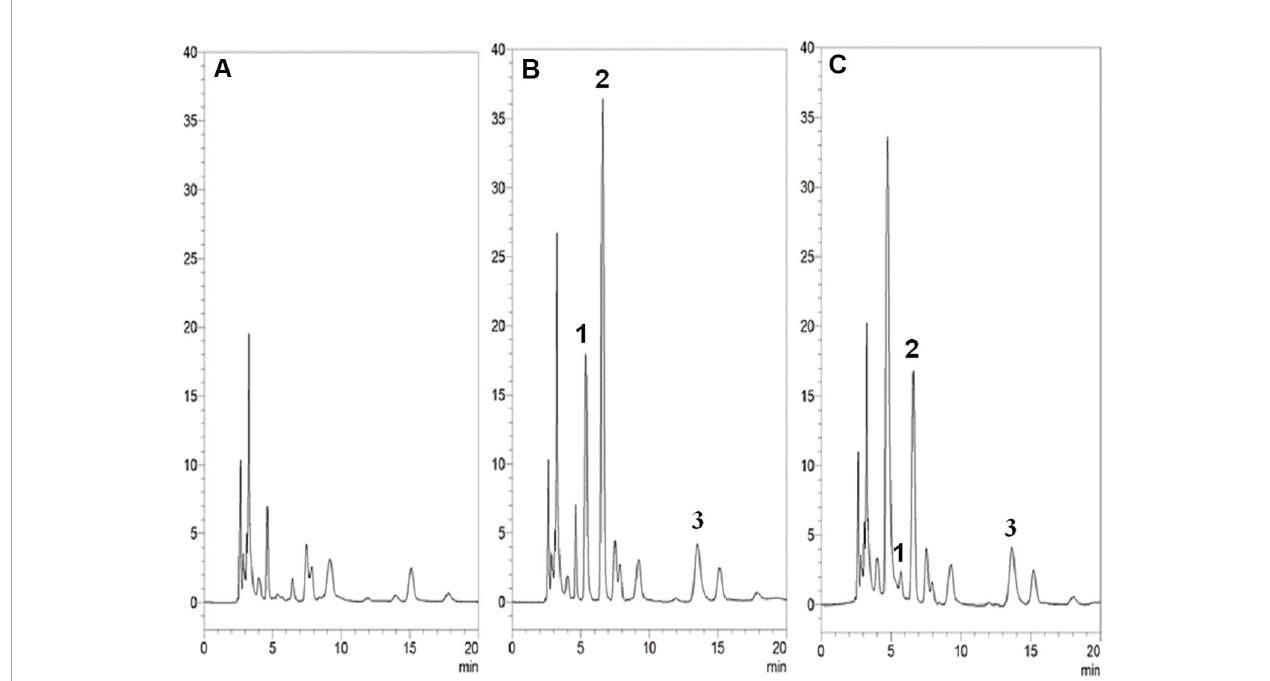
FIGURE 2 | HPLC-UV chromatograms of (A) blank plasma samples; (B) blank plasma samples spiked with 5-FU, 5-FDHU (10 µg/ml) and internal standard (10 µg/ ml); (C) blood sample containing 5-FU (7.9 µg/ml) and 5-FDHU (1.1 µg/ml) collected at 60 min after 5-FU (100 mg/kg, i.v.) administration alone. Peak 1: 5-FDHU and